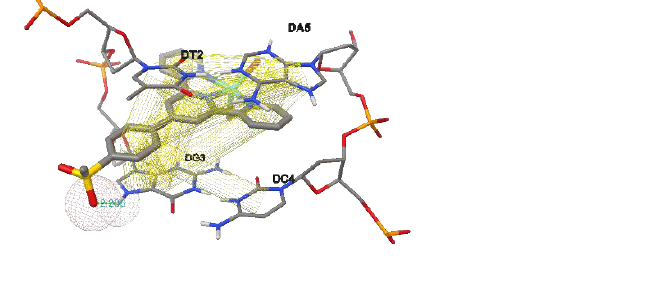
Figure 11. Docking conformation of complex 1 to DNA.